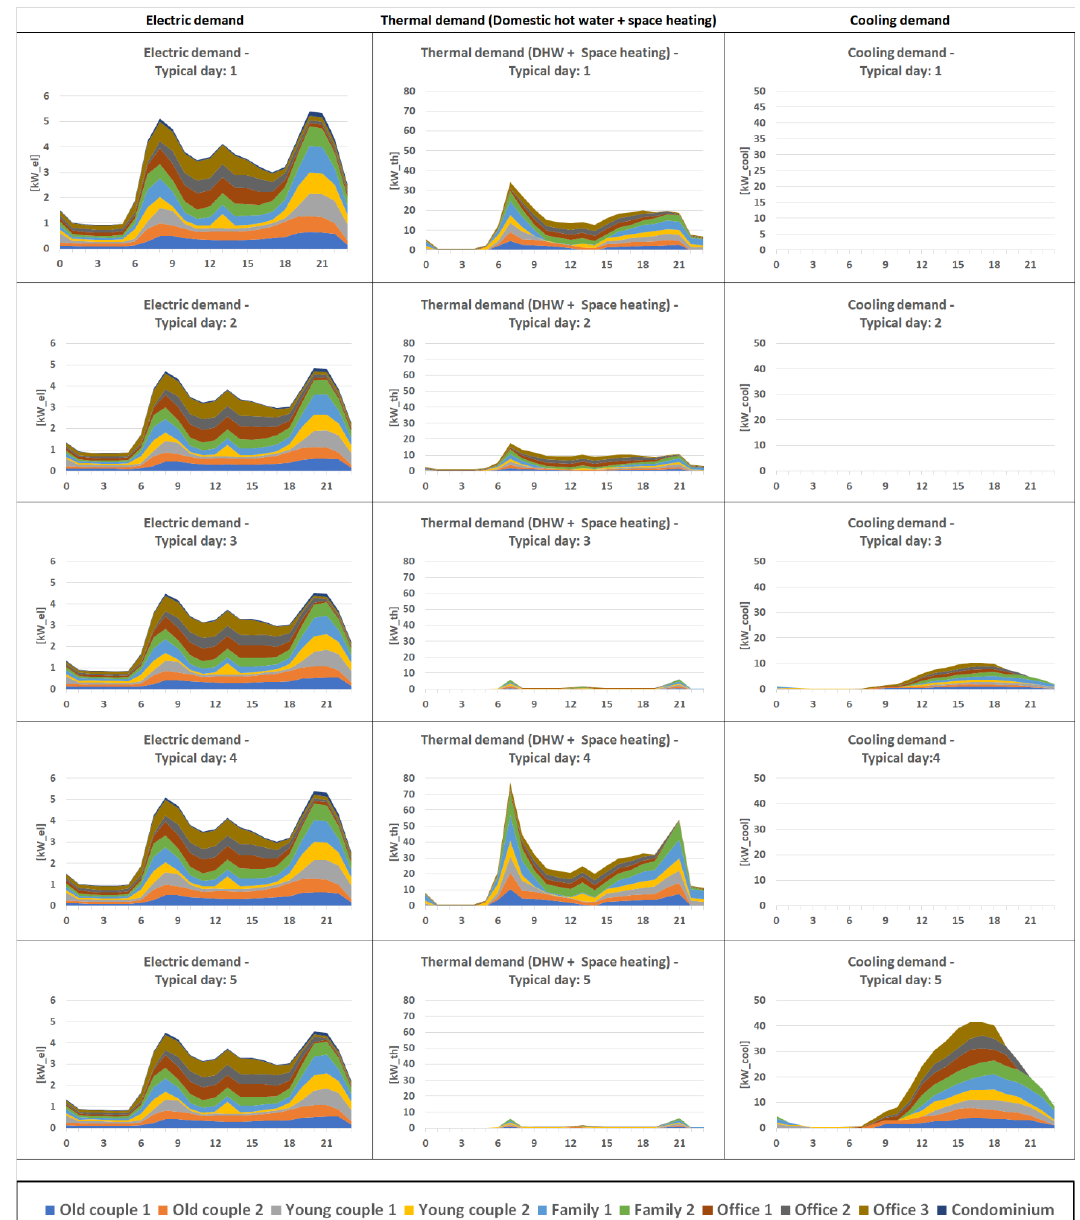
Figure 1. Breakdown of energy demands for each typical day. Note: to appreciate profile shapes, the graph scale is different for each typical day.